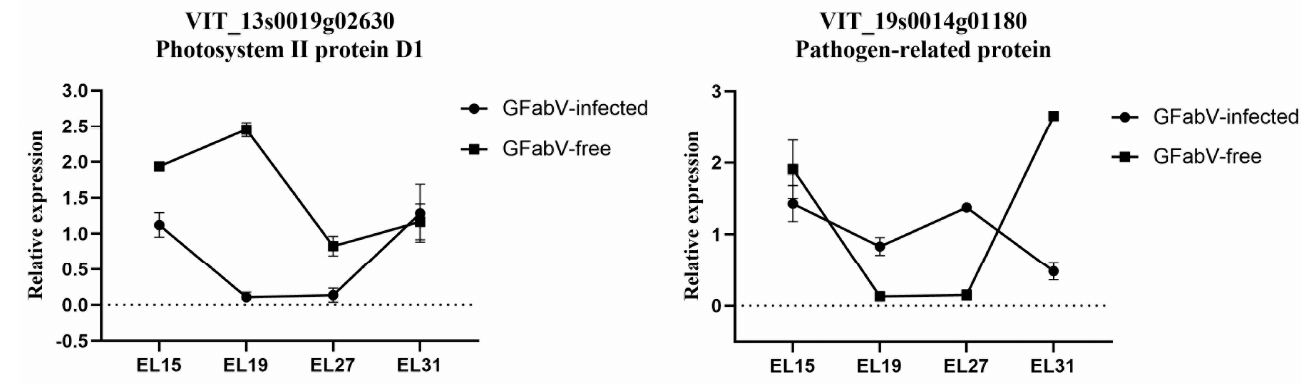
Figure 12. Validation of the expression of genes in ‘Summer Black’ ( a ) berries and ( b ) leaves by RT − qPCR. Error bars represent the standard deviation of three independent bi- ological repeats. Statistically significant results are indicated as P <0.05.